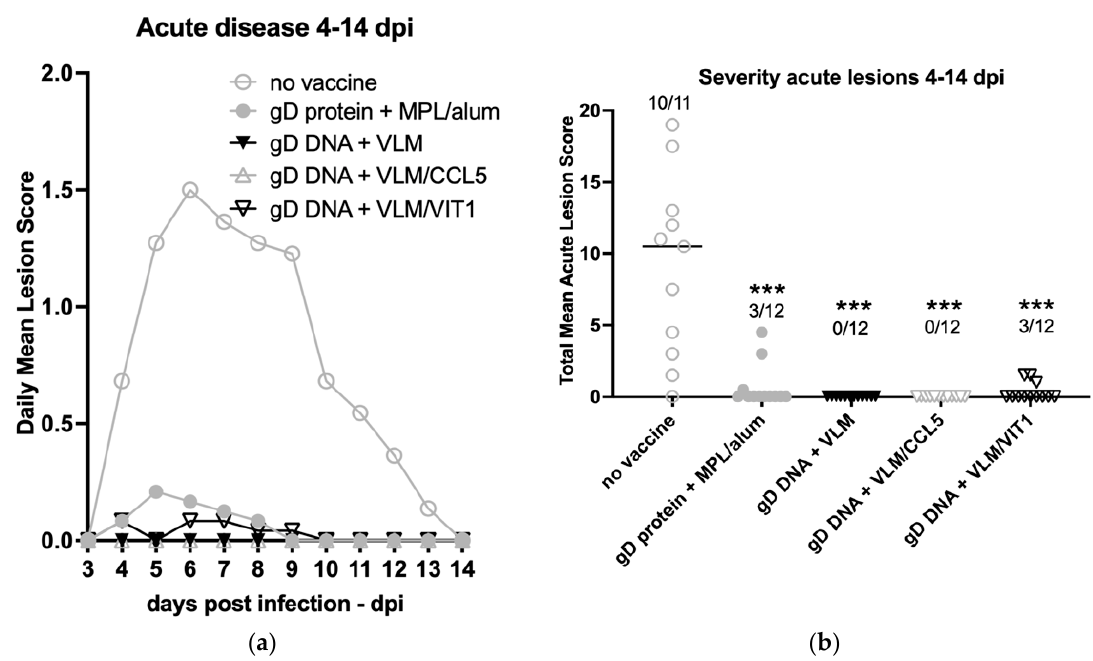
Figure 3. DNA immunisation with VLM vaccines protect against acute disease. Three weeks after the second immunisation, the guinea pigs were challenged with 1 × 10 6 pfu of HSV-2 (MS strain) and the severity of acute disease (0–14 dpi) were scored. No vaccine (saline) and gD protein + MPL were included as negative and positive controls, respectively. ( a ) The score scale for disease severity ranged from 0 to 4 and the total mean acute lesion score are plotted daily. ( b ) The total mean lesion score is compared, with the mean line indicated and proportion of animals that developed acute genital lesions shown with significance analysed via ANOVA with Tukey’s test to adjust for multiple comparisons, P < 0.001 (***).